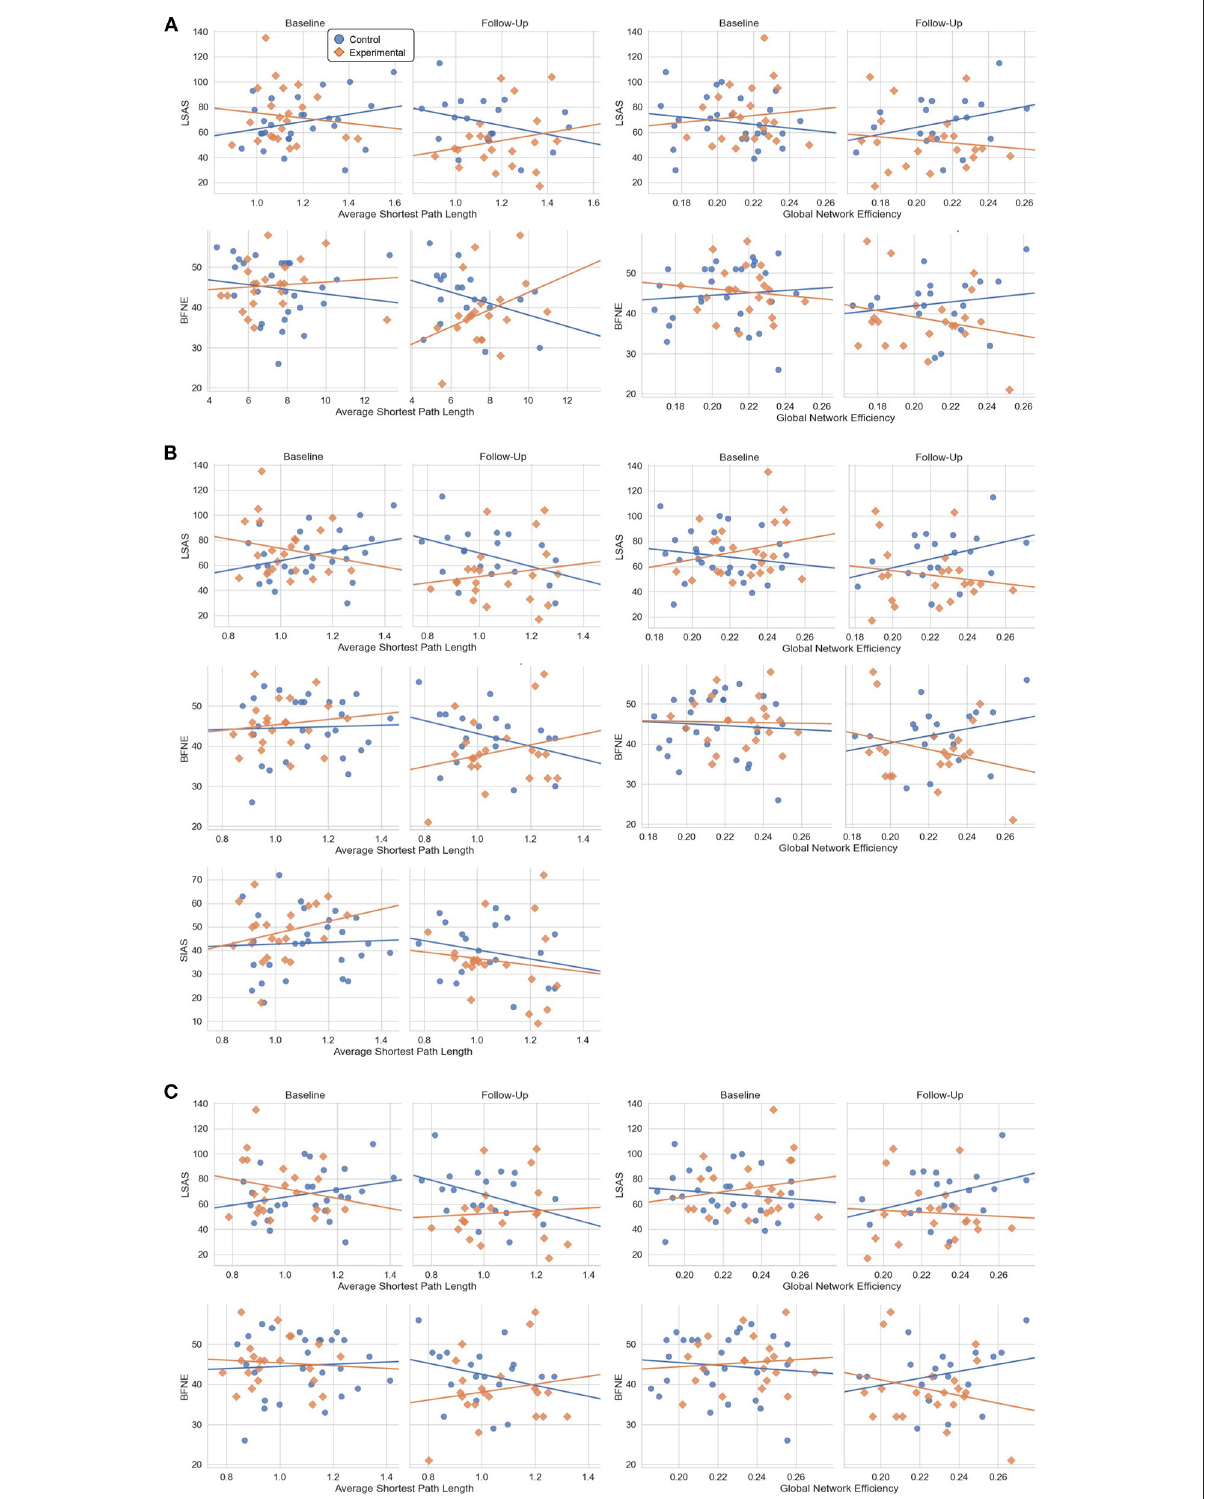
FIGURE5 Scatter plot between the psychometric scale scores and the global network metrics at baseline and follow-up which showed significant results from the general linear model analysis. (A) Results from the AAL atlas. (B) Results from the Brainnetome atlas. (C) Results from the Glasser